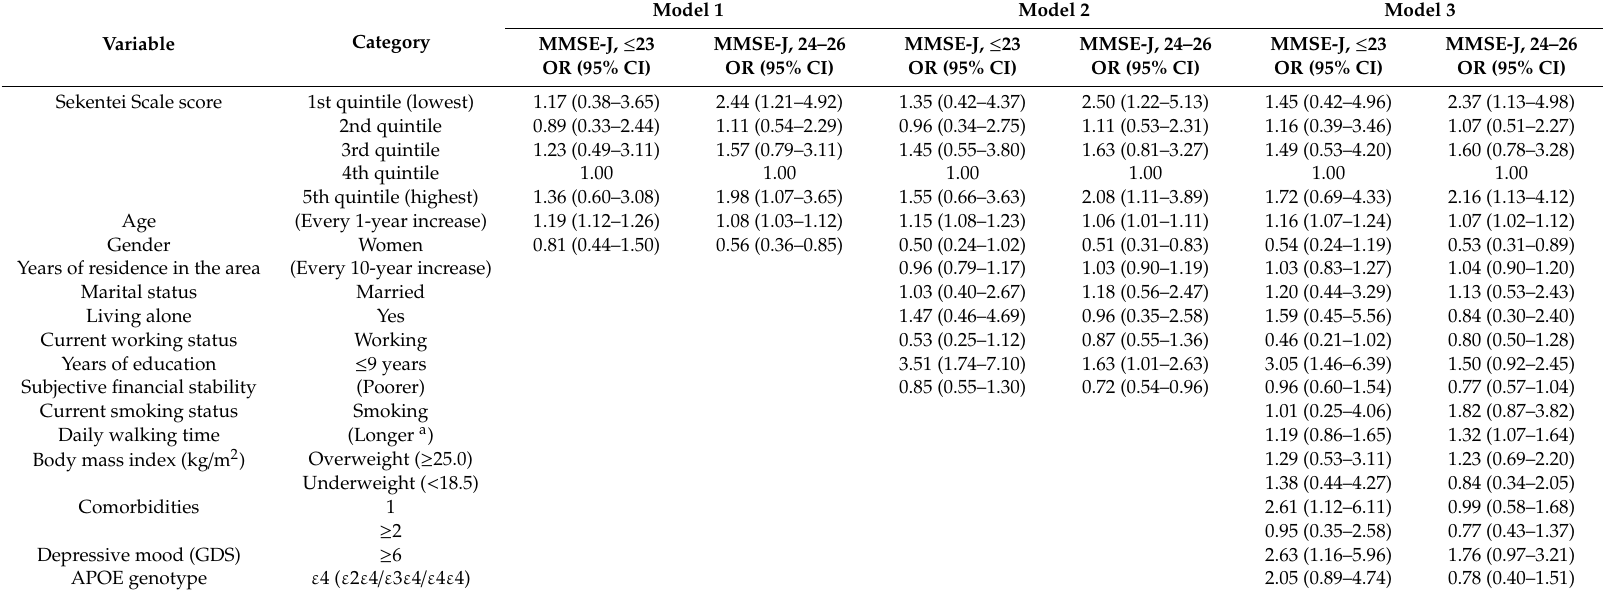
Table 3. Association between sekentei and cognitive function: a multinomial logistic regression